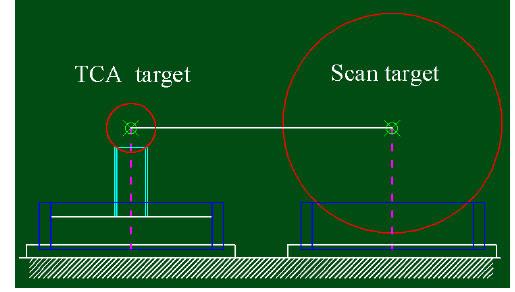
Figure2 Concentric of TCA target and scan target